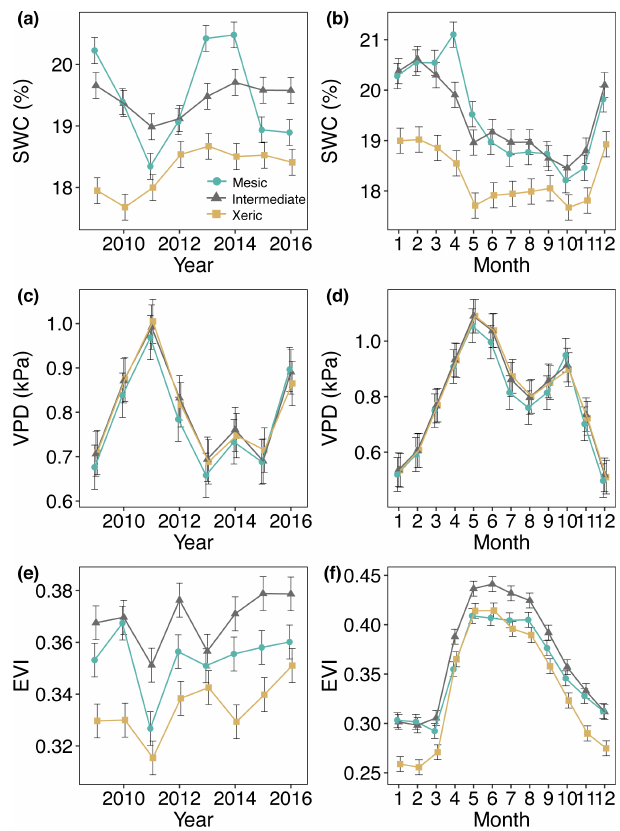
Figure 1. Least squares mean predicted values from mixed models of environmental and structural variables for the years 2009–2016 at the mesic, intermediate and xeric sites, with average annual (a, c, e) and monthly (b, d, f) means of (a, b) soil water content (SWC), (c, d) vapor pressure deficit (VPD) and (e, f) enhanced vegetation index (EVI). Error bars represent standard errors (SE).